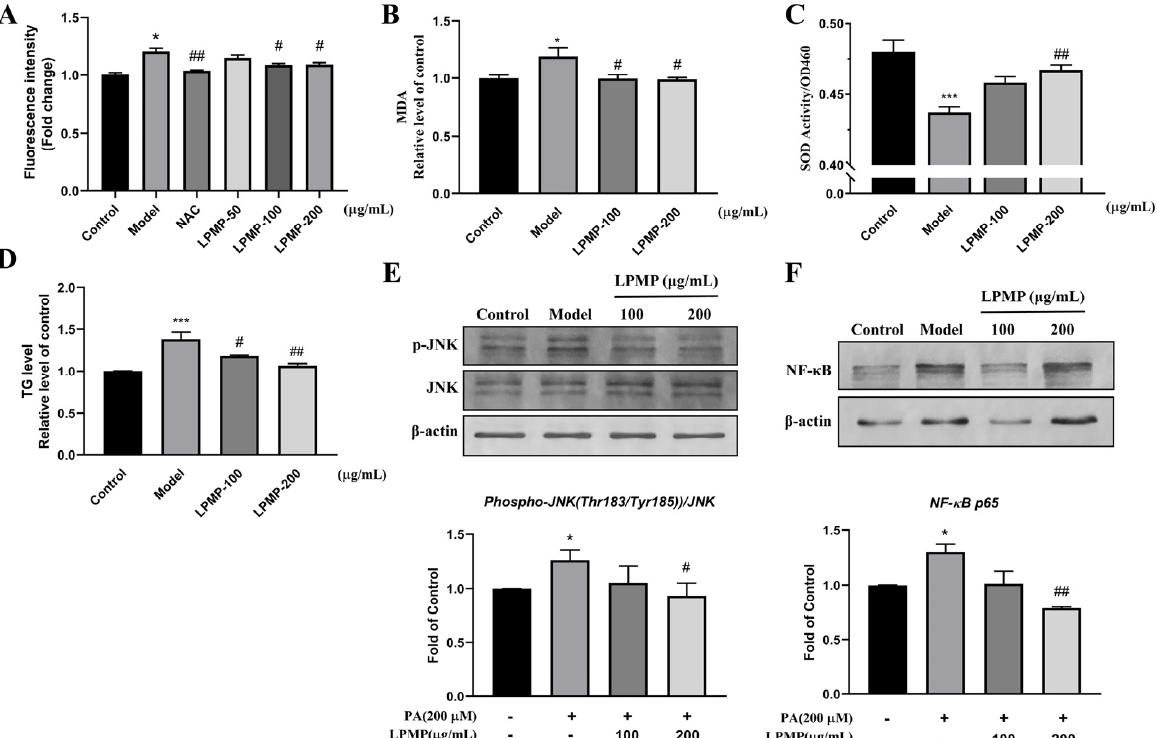
Figure 6. Effect of LPMP on intracellular oxidative stress in HepG2 cells. ( A ) Detection of ROS levels by in situ DCFH-DA probe. Model group (200 μ M PA), positive drug group (100 μ g·mL − 1 NAC). Determination of ( B ) MDA and ( C ) SOD content. ( D ) Measurement of intracellular TG content. ( E ) Phosphorylation levels of JNK protein between the different treatment groups. ( F ) Variation in NF- κ B protein levels between treatment groups. The band density was quantified and β -actin was used as a standard. The results shown are means ± SEM ( n = 3). * p < 0.05, *** p < 0.001 versus control group; # p < 0.05, ## p < 0.01 versus model group.